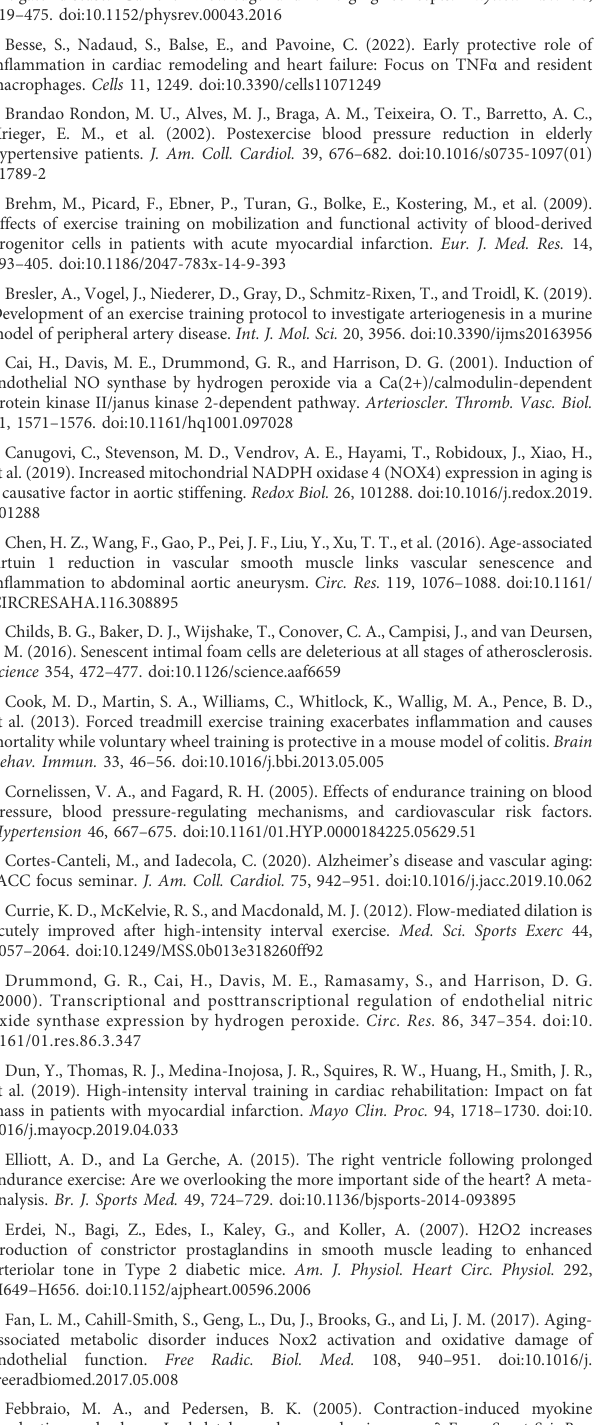
Figueras, M., Busquets, S., Carbo, N., Barreiro, E., Almendro, V., Argiles, J. M., et al. (2004). Interleukin-15 is able to suppress the increased DNA fragmentation